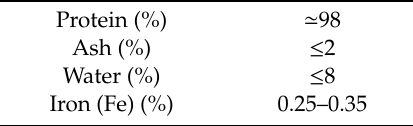
Table 1. Hemoglobin composition (%w /